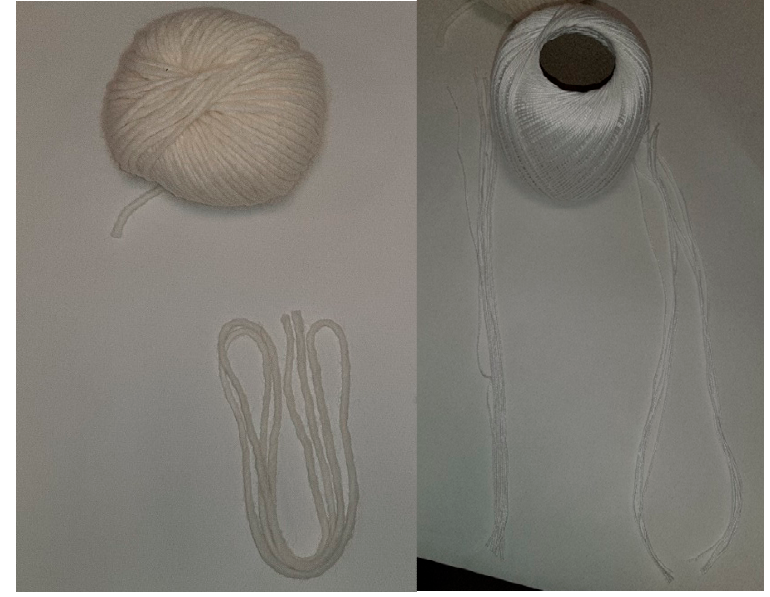
Figure 1. Images of the cotton ( right ) and the wool ( left ) fibers before the etching and the dyeing treatments.